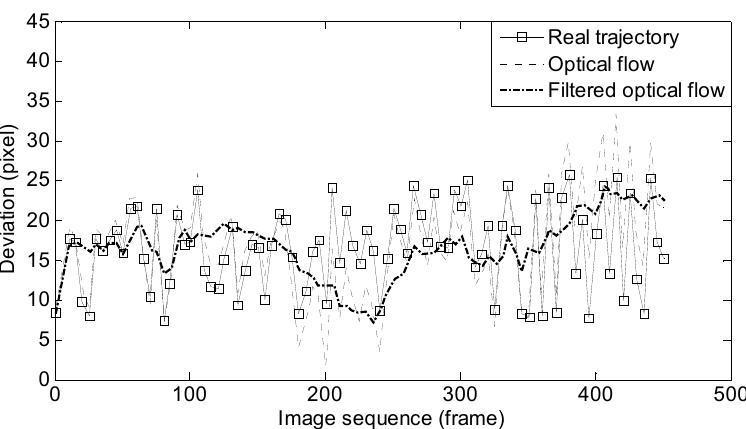
Figure 2. The image sequence that stabilized by optical flow. ( a ) Before stabilization; ( b ) After stabilization.